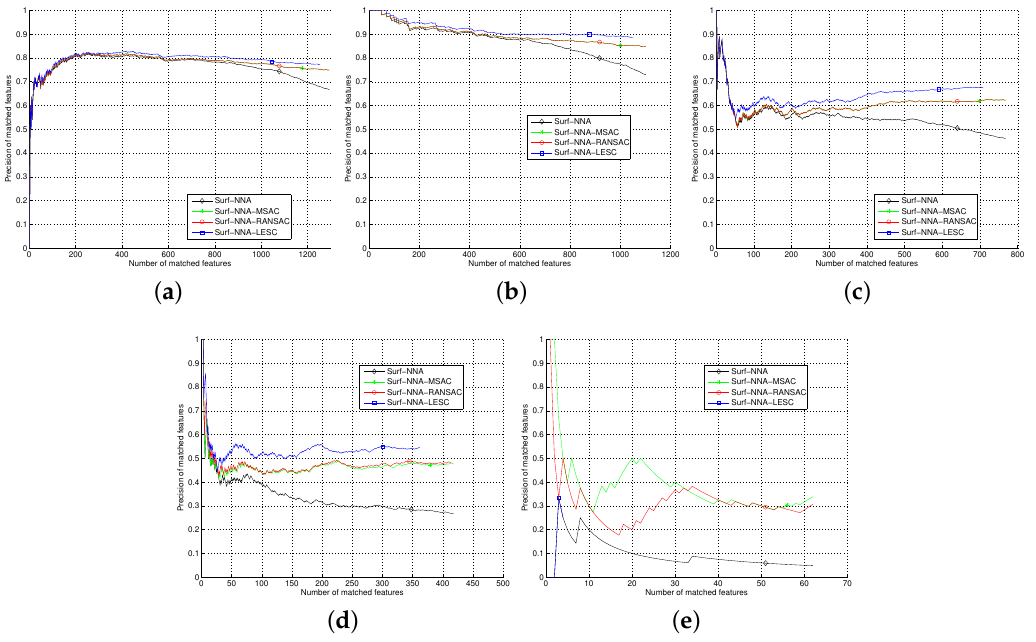
Figure 7. Viewpoint change for the textured scene by the Wall sequence. From ( a ) to ( e ) the degree of change